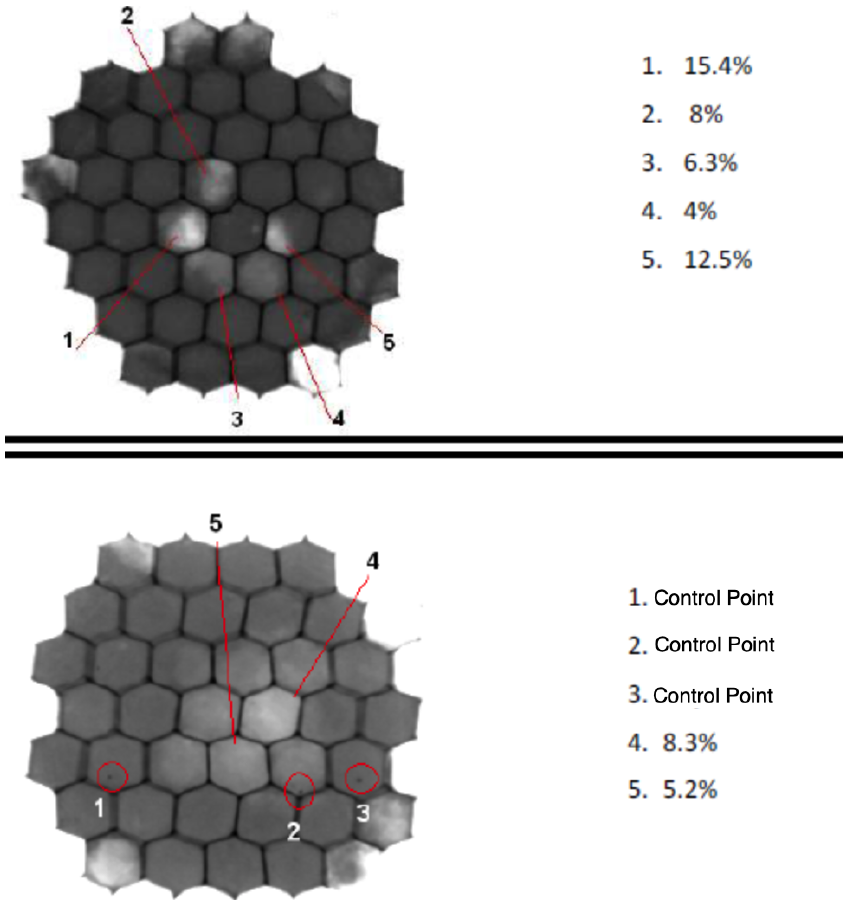
Figure 12. X-ray analysis of two potted spots, each corresponding to different panel thicknesses. In each case, cells with spots showing brightness deviations are